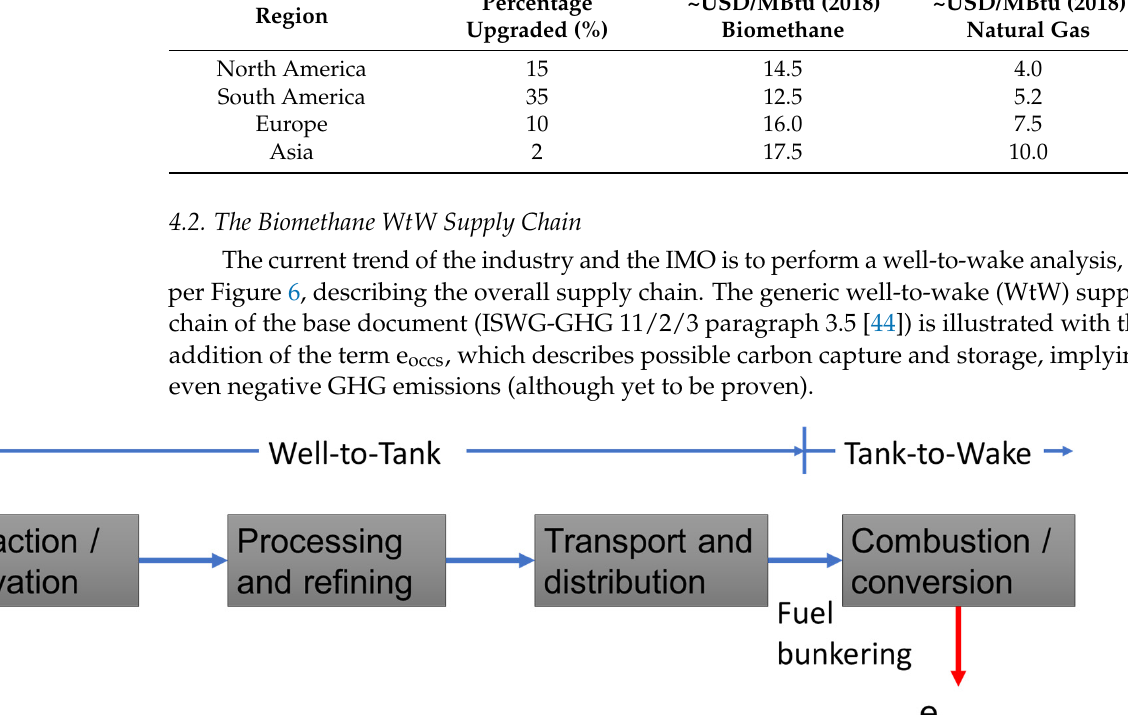
Figure 7. Cost constituents of biomethane from source to vessel and port.